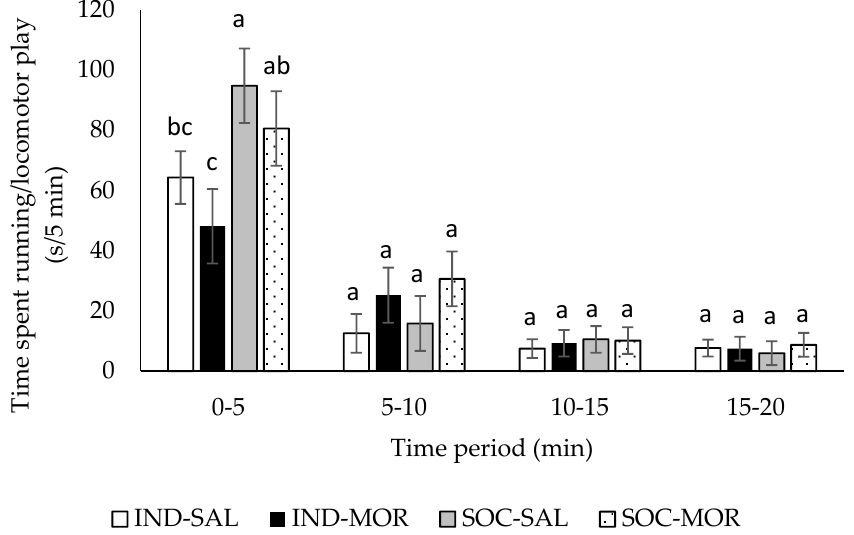
Figure 1. Total time calves spent running/locomotor play (s/5 min; Least square means ± SEM) during a 20 min observation period in an arena test. Calves received an injection of saline and were tested individually (IND-SAL, n = 12) or in pairs (SOC-SAL, n = 12), or received an injection of morphine and were tested individually (IND-MOR, n = 12) or in pairs (SOC-MOR, n = 12). For each time period, least square means with different superscripts differ at p < 0.05.